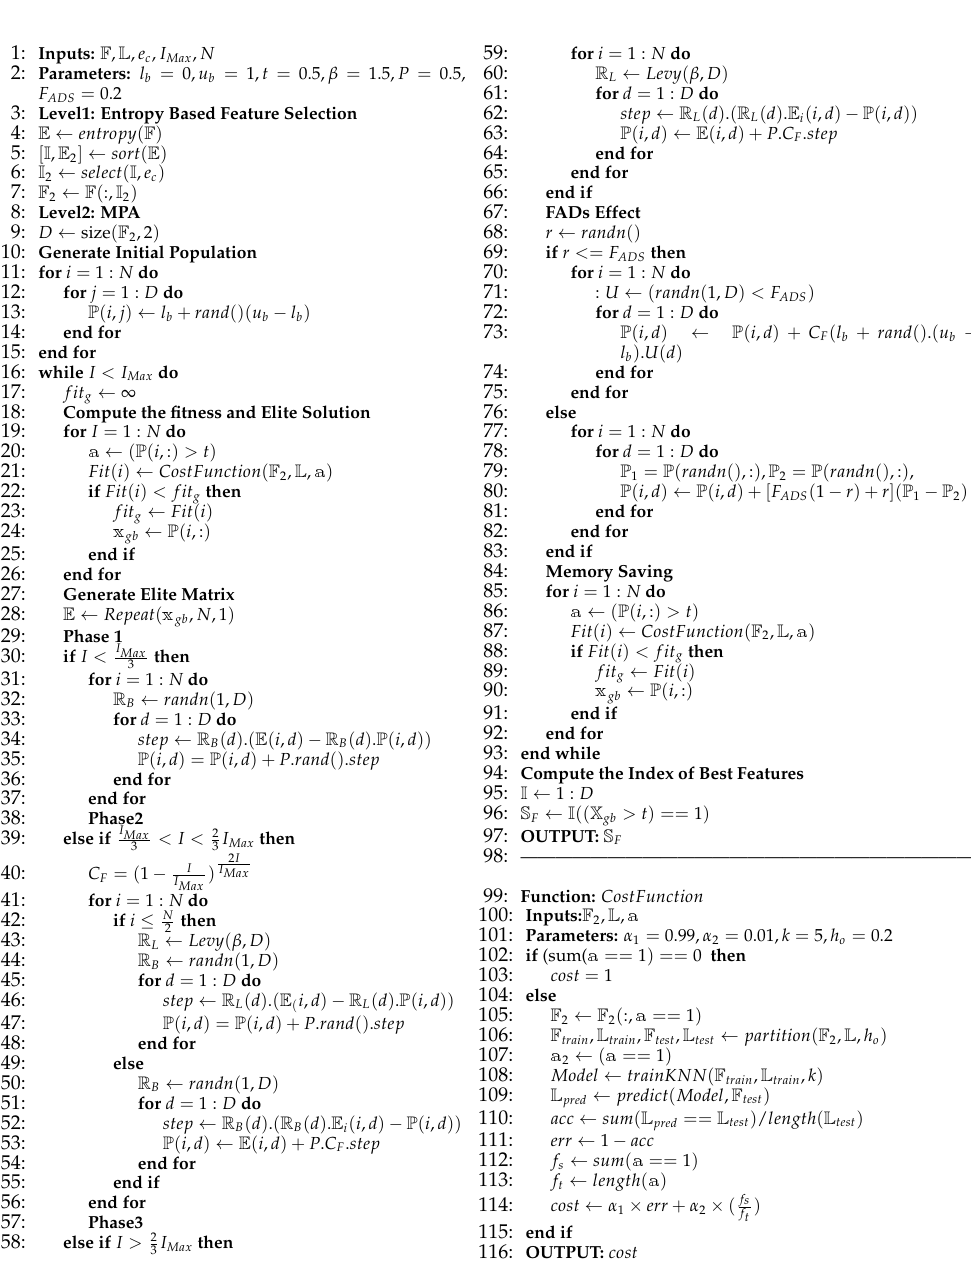
Algorithm 1 ECMPA for feature